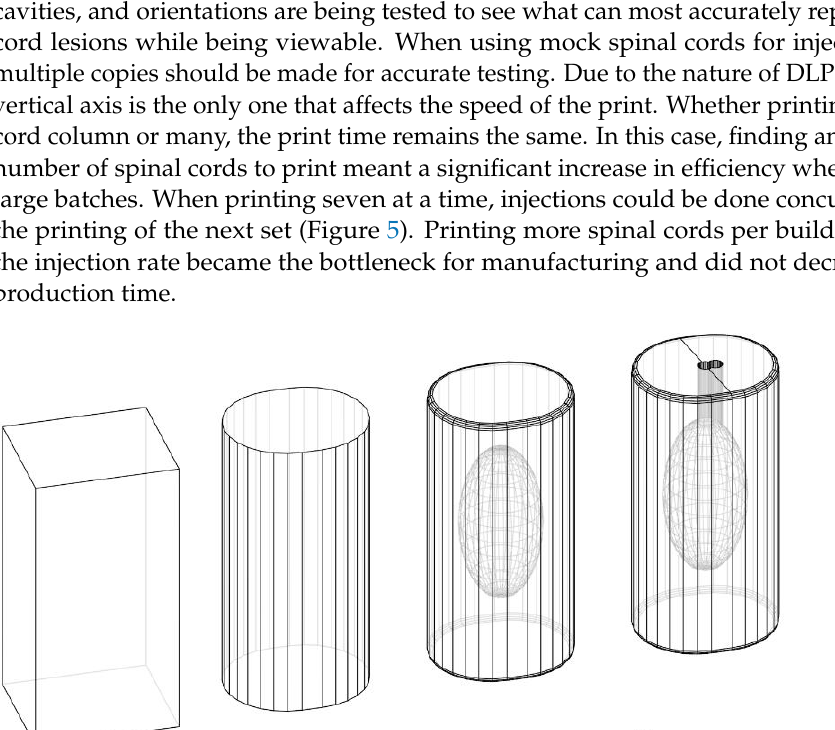
Figure 5. One set of printed spinal cords after printing and removal of uncured material. aCSF is added at this stage post printing to create the organ mimic. 2.3. Mock Ureters The creation of mock ureters, along with other tube-like structures found within the body require relatively simple shapes to be created. Other channels, such as the trachea, fallopian tubes, and bronchiole tubes, have different wall thicknesses, diameters, and length, but can utilize a similar method of creation. Material selection should serve to mimic existing structures with commonly used biomaterials. Animal derived materials such as collagen, gelatin, and plant derived materials, such as alginate, are a good foun-